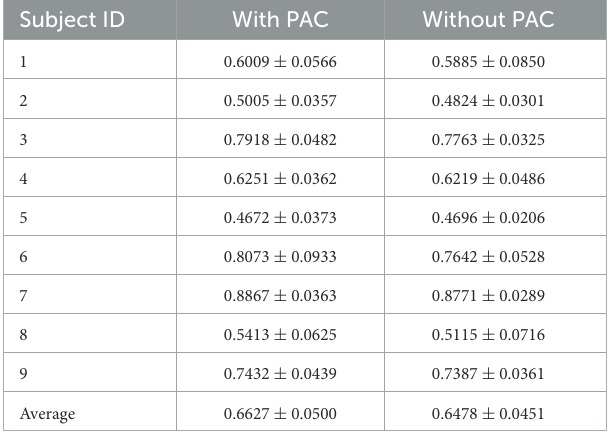
TABLE 4 Ablation experiment on fingerflex